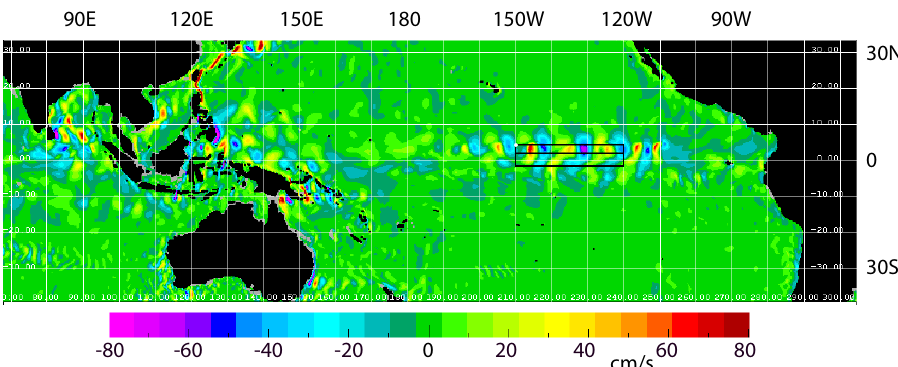
Fig. 1. Meridional velocity (cms − 1 ) at 30m depth in September 1993 (from an OCCAM restart dataset). The rectangular areas outline the regions used for the flux study described later in this